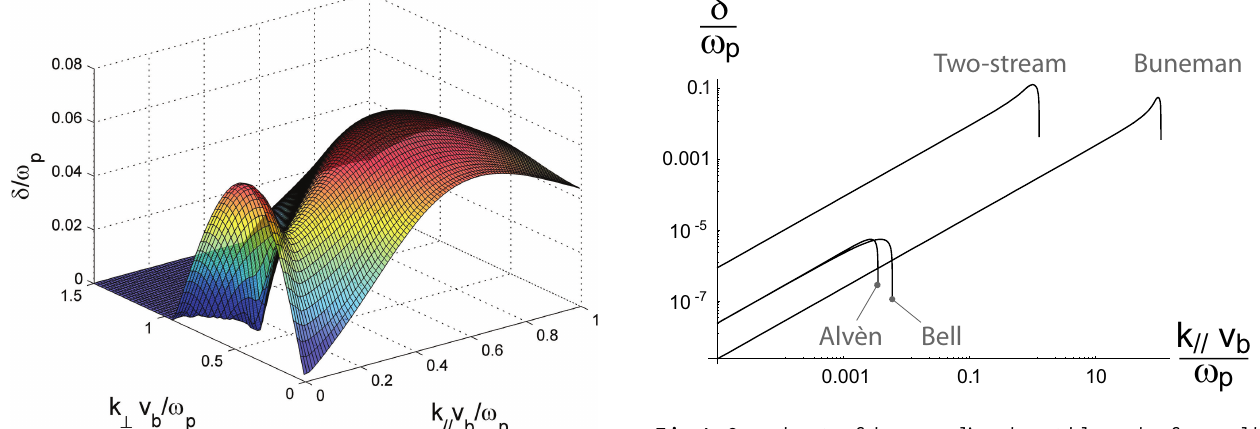
Fig. 4. Growth rate of the flow aligned unstable modes for a cold proton beam with v b = 0 . 4 c interacting with a cold plasma 100 times